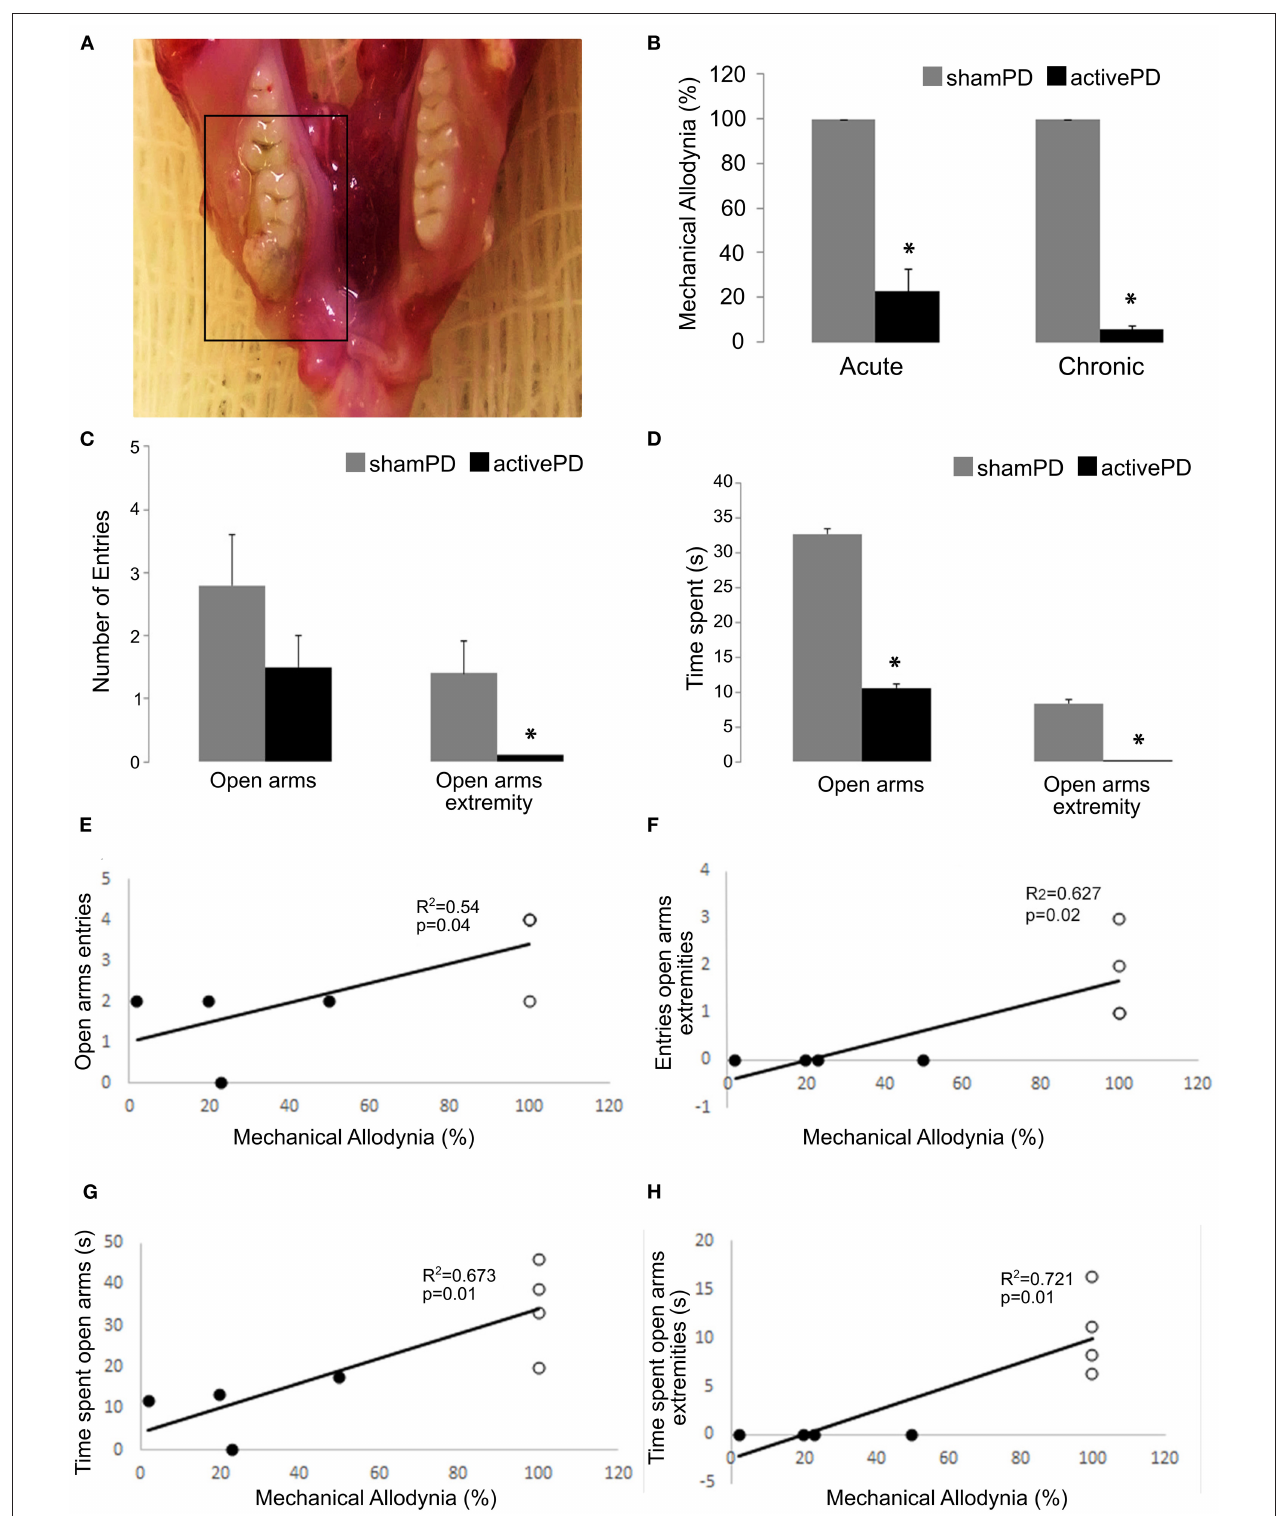
FIGURE 2 | Illustrative case of moderate to severe active periodontal disease . (A) Reduction of mechanical allodynia threshold in Acute and Chronic groups at endpoint. (B) Increase in anxiety-like behaviors in the activePD animals compared to shamPD animals of the Acute group. (C,D) Positive correlation between mechanical allodynia thresholds and anxiety-like behaviors in the Acute group (E–H) . PD, periodontal disease. *indicates p < 0.05.